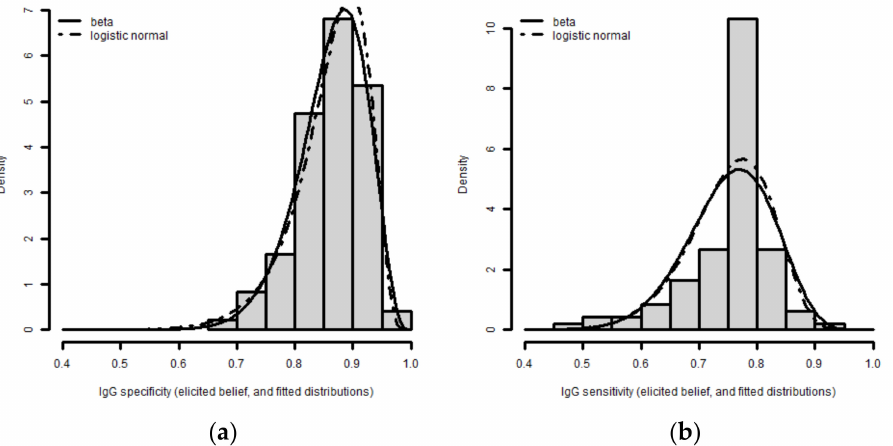
Figure 4. IgG uncertainty in ( a ) specificity and ( b ) sensitivity.